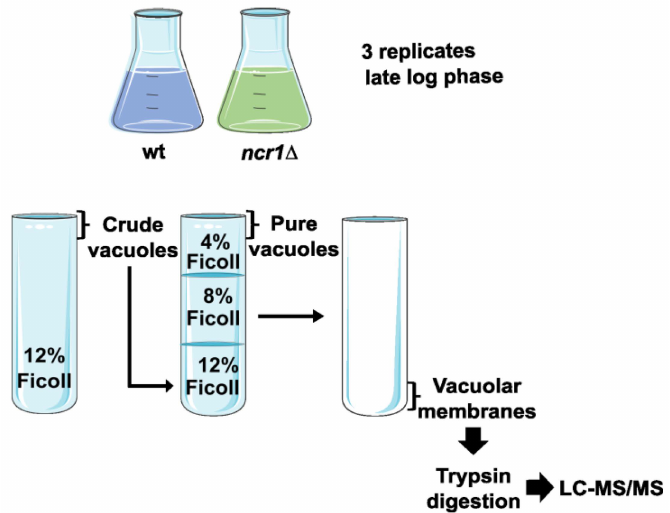
Figure 1. Overview of the experimental design. Wild-type (wt) and ncr1 ∆ cells were grown in SC medium to late exponential phase [late log; (OD 600 nm ∼ = 2)]. Vacuoles were isolated by density centrifugations using Ficoll gradients and vacuolar membranes recovered after osmotic lysis of vacuoles. Samples were then digested with trypsin, and protein identification and quantitation were performed by